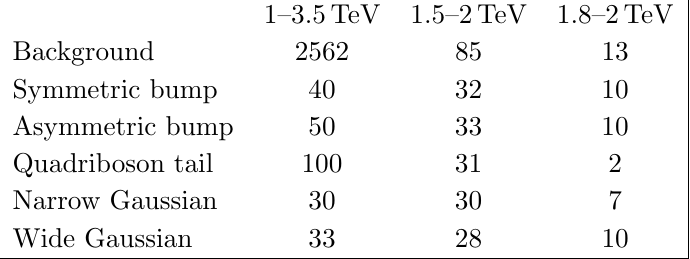
Table 1 . Number of mean background and signal events in selected invariant mass intervals.